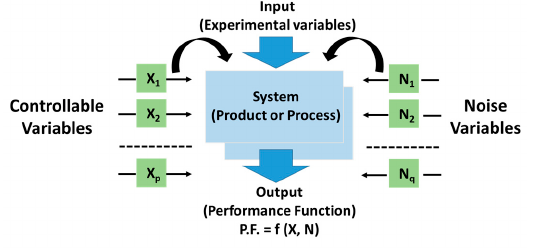
Figure 9. Schematic illustration of a system (product or process) at the design stage.